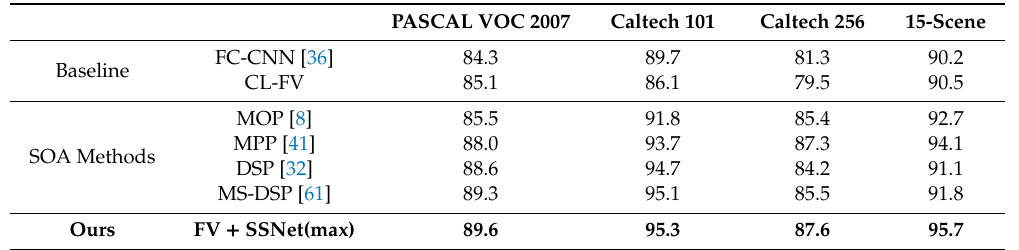
Table 3. Comparison with the baselines and state-of-the-art methods based on CNN local features (MAP in